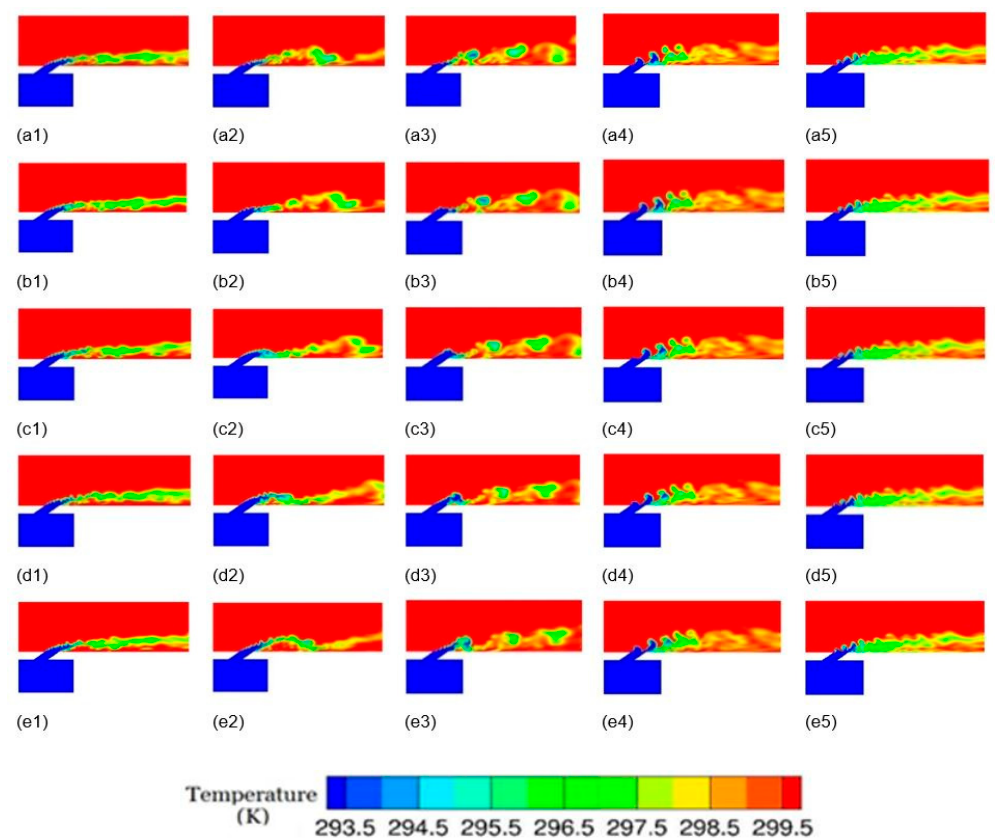
Figure 39. ( a1 – e1 ) The instantaneous temperature contours for the central cross section using the FLUENT, LES, Smagorinsky–Lilly model for M = 1.0, 2 Hz. ( a2 – e2 ) The instantaneous temperature contours for the central cross section using the FLUENT, LES, Smagorinsky–Lilly model for M = 1.0, 32 Hz. ( a3 – e3 ) The instantaneous temperature contours for the central cross section using the FLUENT, LES, Smagorinsky–Lilly model for M = 1.0, 90 Hz. ( a4 – e4 ) The instantaneous temperature contours for the central cross section using the FLUENT, LES, Smagorinsky–Lilly model for M = 1.0, 268 Hz. ( a5 – e5 ) The instantaneous temperature contours for the central cross section using the FLUENT, LES, Smagorinsky–Lilly model for M = 1.0, 536 Hz. ( a ) t /period = 0 ( b ) t /period = 0.2 ( c ) t /period = 0.4 ( d ) t /period = 0.6 ( e ) t /period = 0.8.